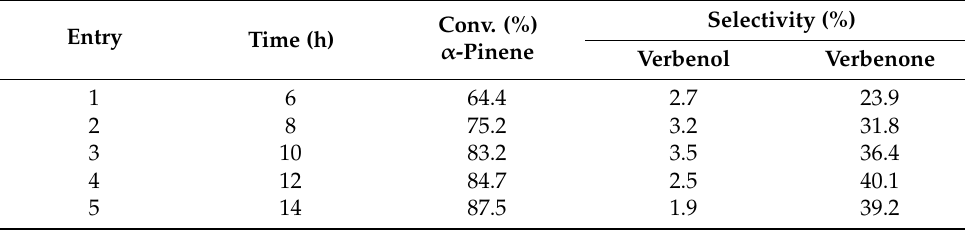
Table 3. Variation in the time of oxidative synthesis of verbenone by α -pinene and TBHP 4 . Entry Time (h)